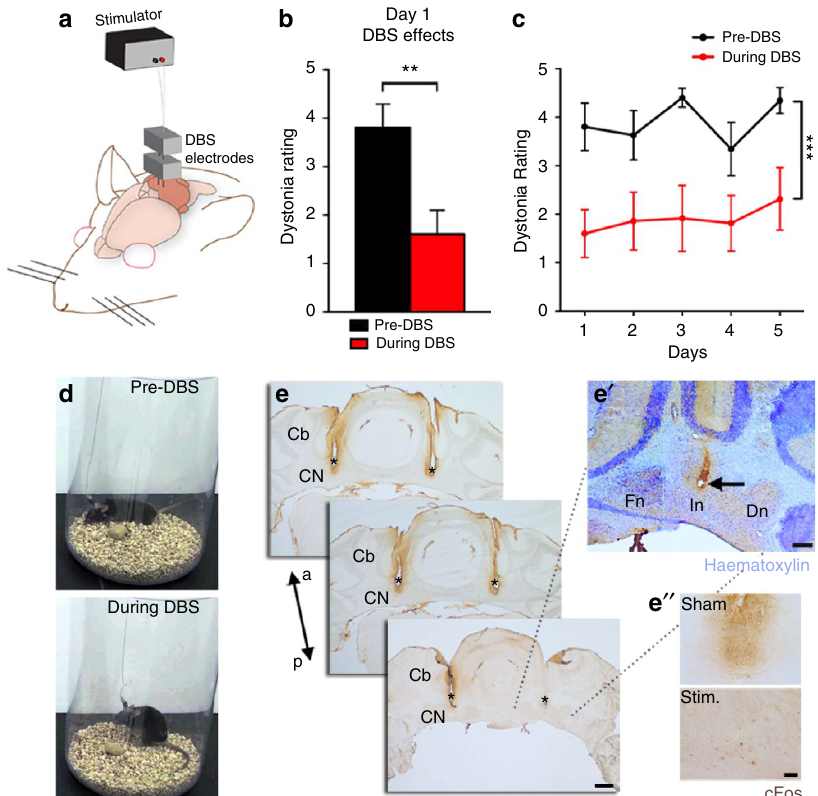
Figure 8 | Deep brain stimulation of the interposed cerebellar nuclei restores mobility in severely dystonic mice. ( a ) A schematic example of DBS targeting into the cerebellum. ( b ) Dystonia rating before and during DBS stimulation of the interposed cerebellar nucleus in naive Ptf1a Cre ;Vglut2 fx/fx mutant mice ( P ¼ 0.0014; n ¼ 7 mice; Student’s paired t -test). There is no significant difference between pre-DBS and post-DBS suggesting limited residual